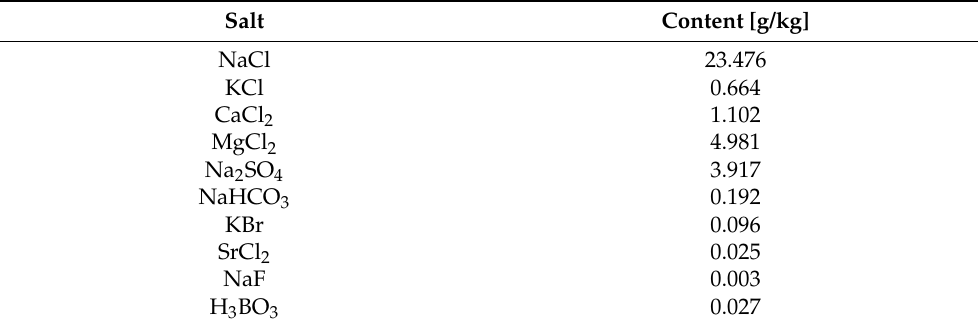
Table 4. Chemical composition of artificial seawater.